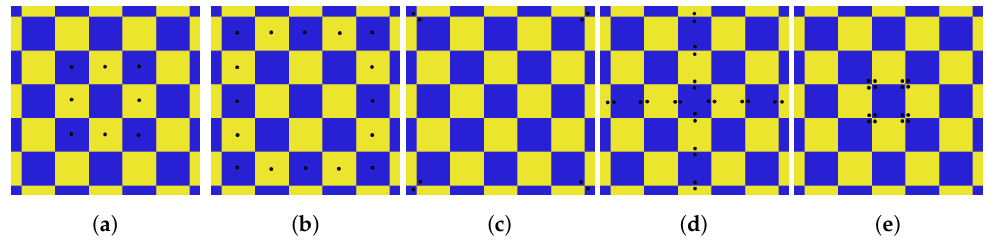
Figure 5. Checkerboard model. An optimization algorithm evaluates the key points in five steps, in each of which different point sets ( a – e ) are matched to find the region which maximizes the similarity degree between the projected model and the image, as described in [12].